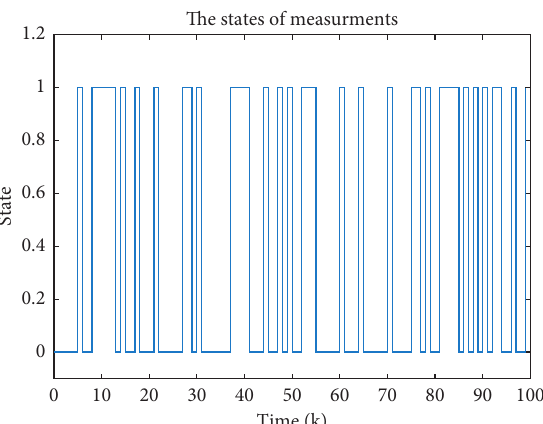
Figure 4: The jump of Bernoulli distribution in Case 2.